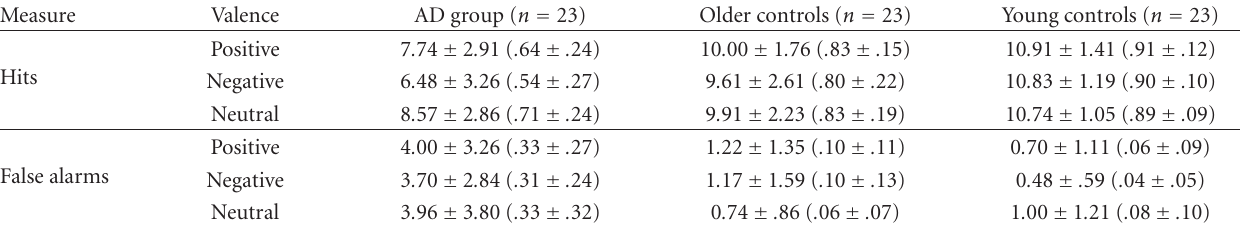
Table 2: Mean number ± standard deviation (proportion ± standard deviation) of hits and false alarms for positive, negative, and neutral stimuli in the AD and control groups. Maximum per category = 12.